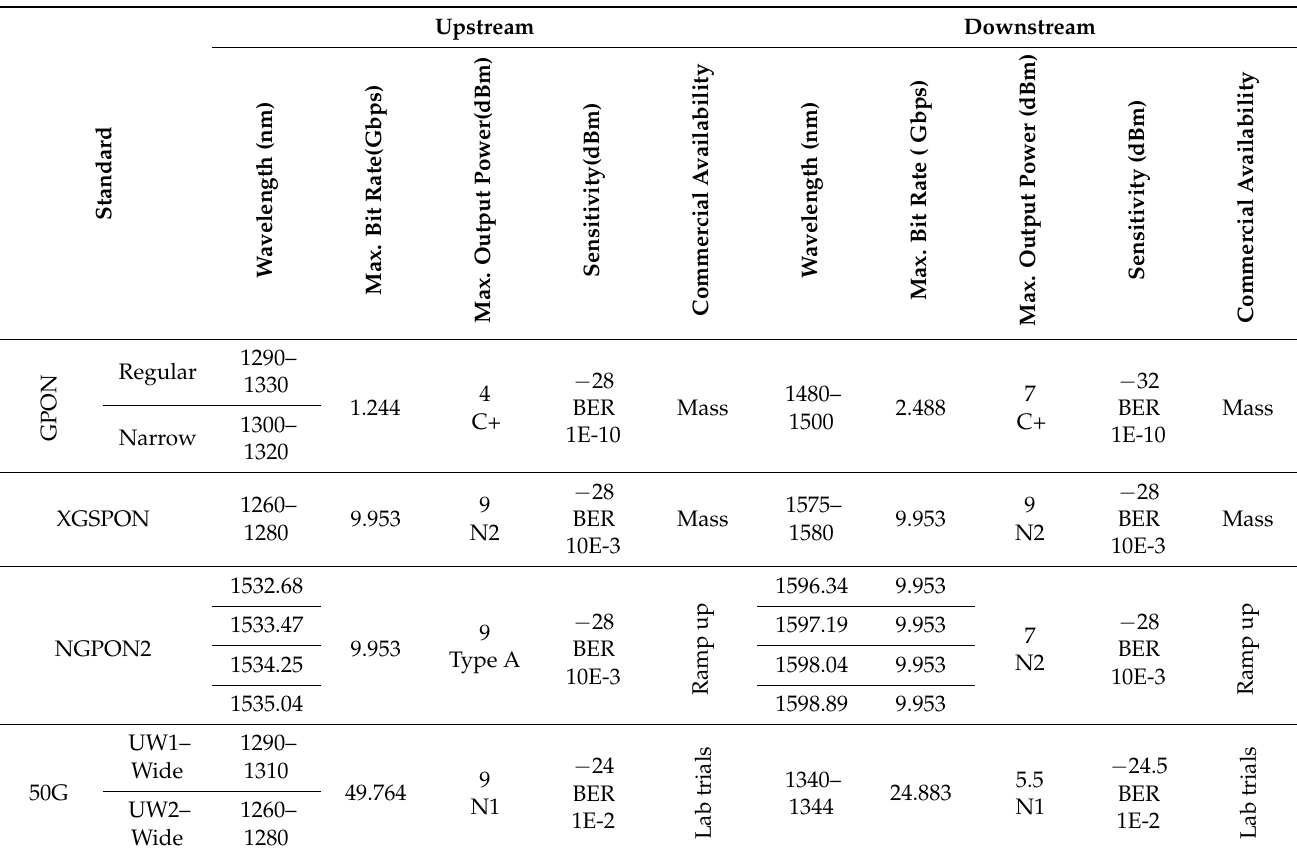
Table 1. PON technology optoelectronic key performance